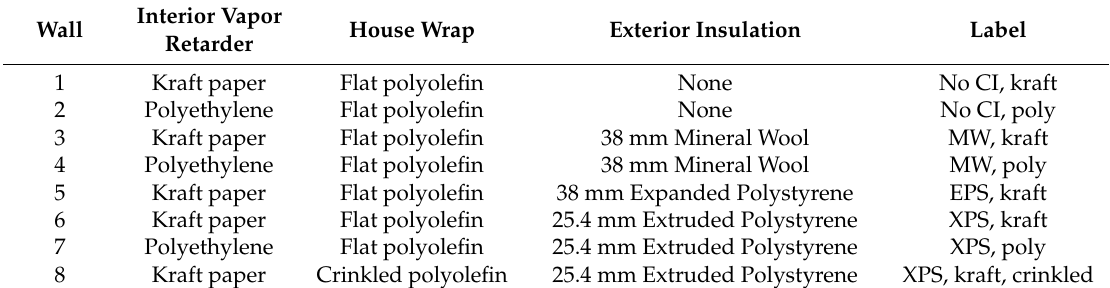
Figure 1. Test structure for field measurements with 8 different wall assemblies. Table 1. Wall configuration summary.